Question: Compose a caption that would accompany this figure in a paper.
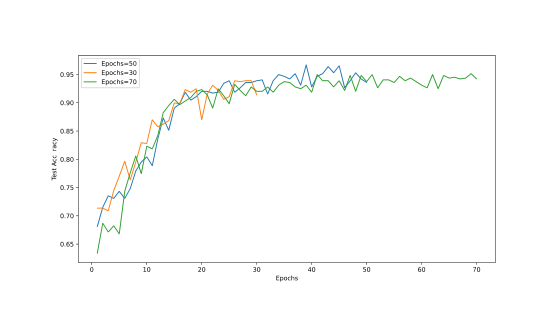
Answer: Accuracy under different Epochs.